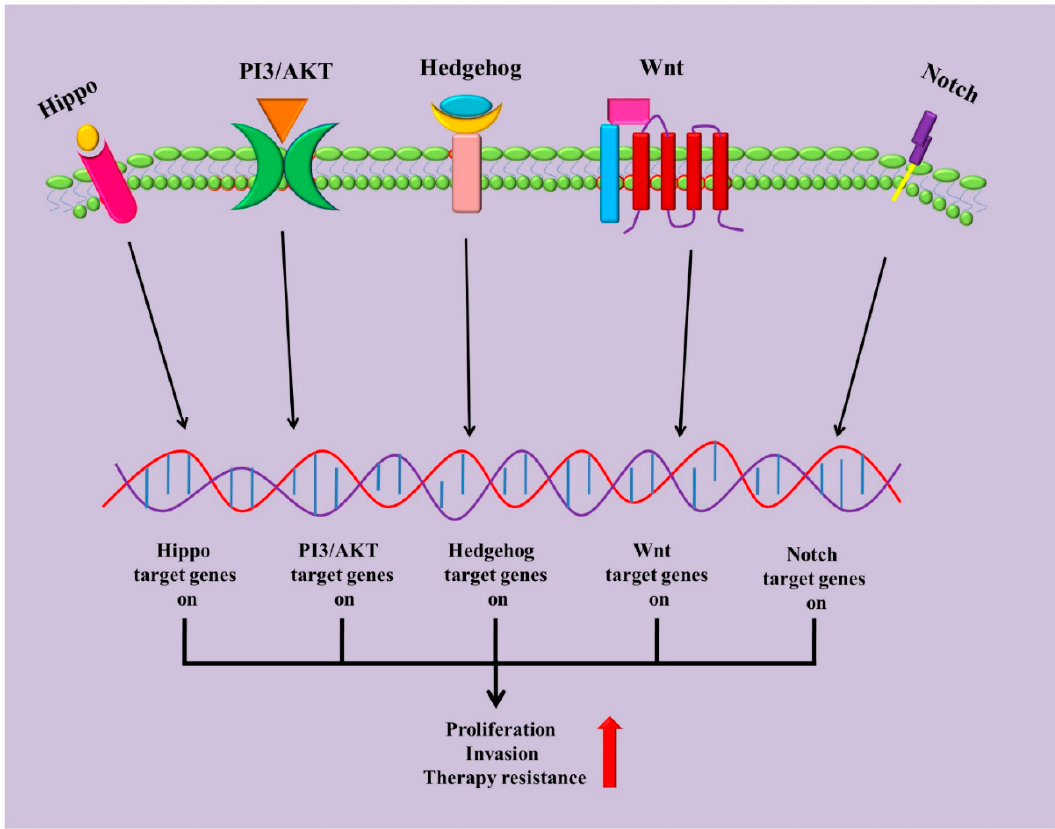
Figure 2. Overview of signalling pathways defining colorectal CSC populations. Wnt, Notch, Hedgehog, PI3 / AKT and Hippo pathways are implicated to regulate CSC populations, leading to increase in proliferation, invasiveness, and most importantly, resistance to therapies.